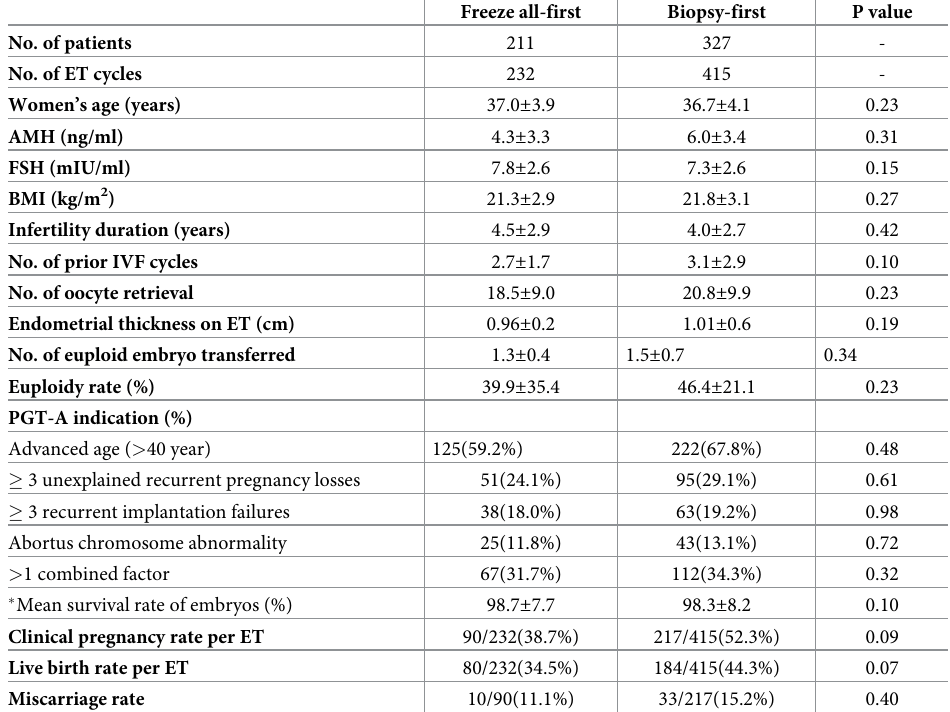
Table 1. Clinical characteristics of women with preimplantation genetic testing for aneuploidy in freeze all-first (freeze all first and biopsy) versus biopsy-first (biopsy first and freeze normal). Freeze all-first Biopsy-first P